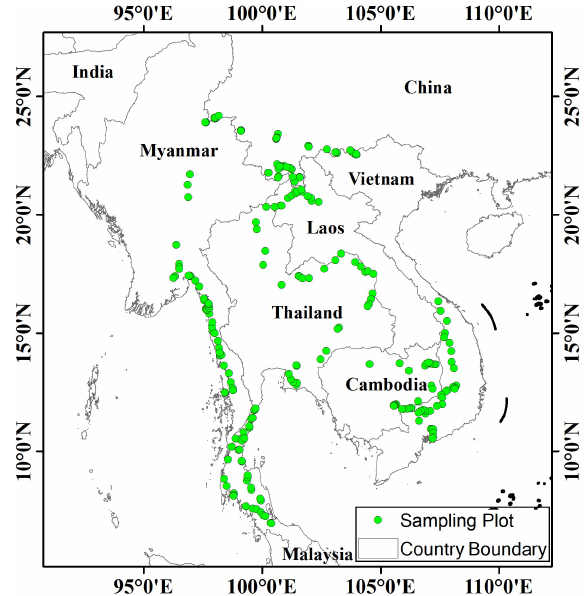
Figure 1. Sampling plot localities within rubber plantations in the